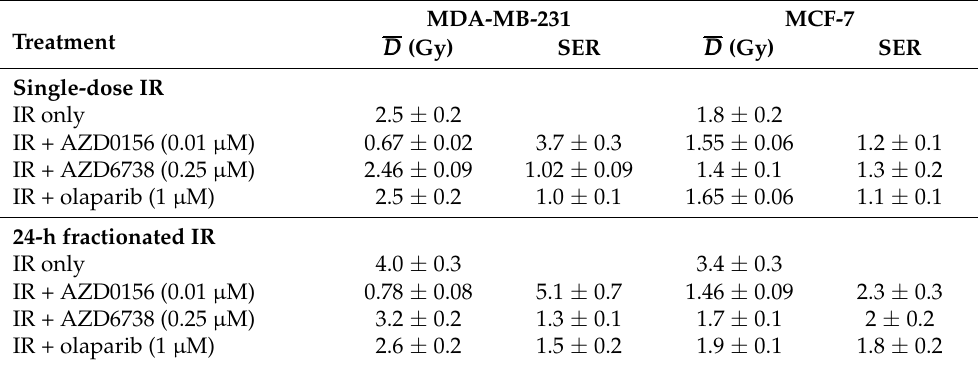
Table 2. Mean inactivation dose ( D ) of single-dose and 24-h fractionated IR with and without DDR inhibition and the sensitizer enhancement ratio (SER) of each DDR inhibitor in MDA-MB-231 and MCF-7 cells. D values were estimated by calculating the area under the survival curves in Figures 5 and 6. SER values were calculated as the D for the IR-only groups divided by the D for the IR and drug combination groups. Data are shown as mean ± SD of three independent experiments performed in duplicate or triplicate